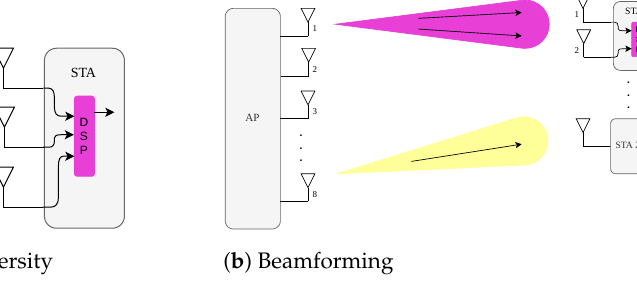
Figure 4. (MU-)MIMO